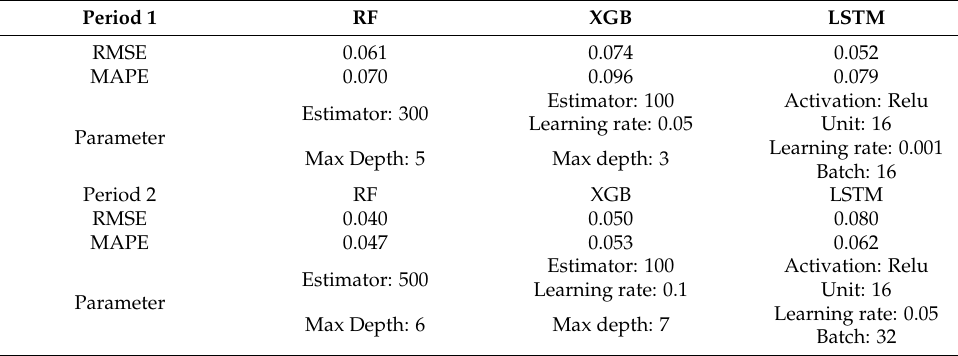
Table 5. Performance of the models by period.